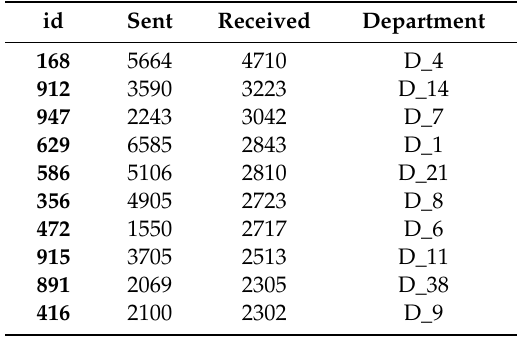
Table 3. Individual level statistics (top 10 in emails